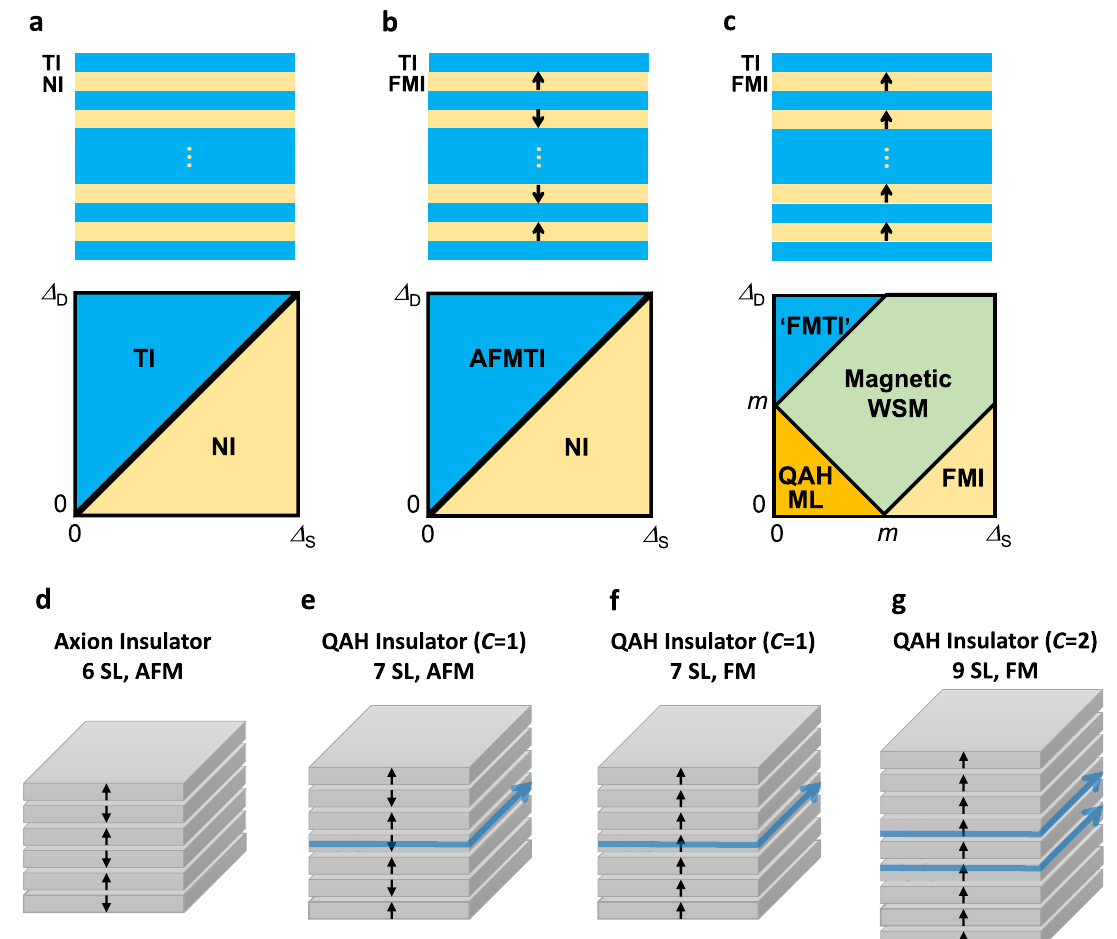
Fig. 2 Topological phases of MnBi 2 Te 4 -family materials. a – c Topological phase diagrams of NI/TI superlattice ( a ), FMI/TI superlattice in AFM con fi guration ( b ), and FMI/TI superlattice in FM con fi guration ( c ). d – g Schematic topological phases of MnBi 2 Te 4 thin fi lms or fl akes in different thickness and magnetic con fi